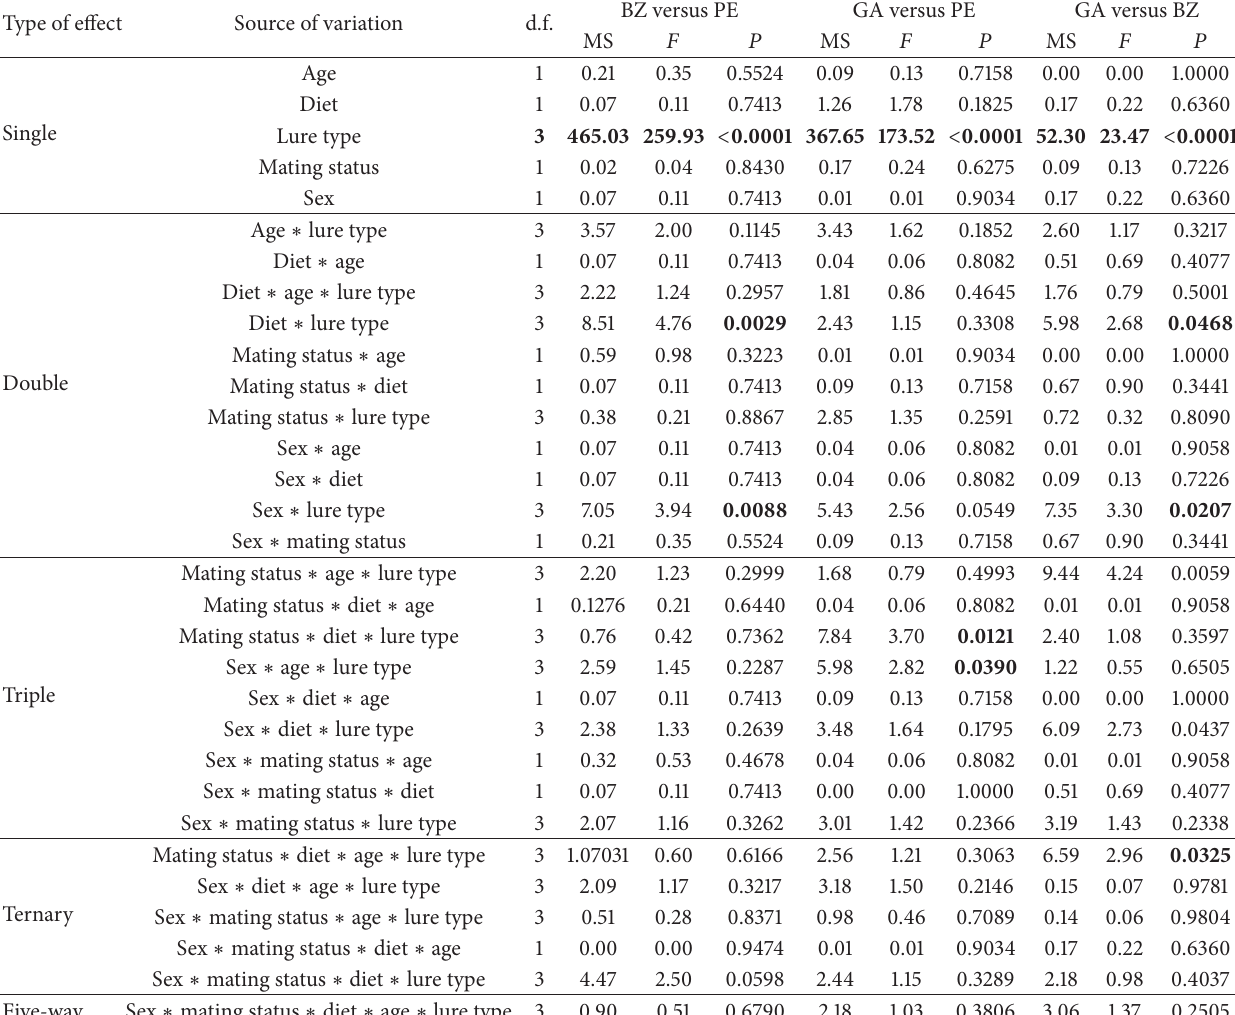
Table 1: Standard least squares analyses of variance testing for effects of age, diet, lure type, mating status, and sex and their interactions on response of C. nenuphar to single components of benzaldehyde (BZ), plum essence (PE), and grandisoic acid (GA). Type of